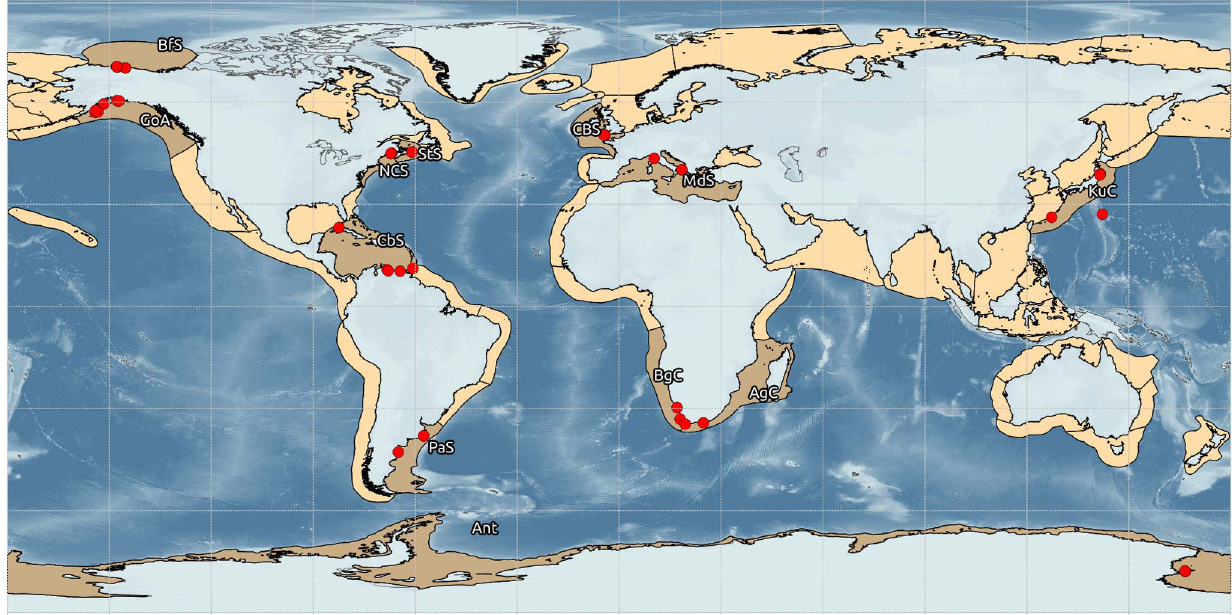
Figure 1. Global distribution of the sampling sites within the Large Marine Ecosystems (LME). BfS: Beaufort Sea; GoA: Gulf of Alaska; CBS: Celtic-Biscay Shelf; StS: Scotian Shelf; NCS: North East US Coast Shelf; KuC: Kuroshio Current; MdS: Mediterranean Sea; CbS: Caribbean Sea; AgC: Agulhas Current; BgC: Benguela Current; PaS: Patagonian Shelf.